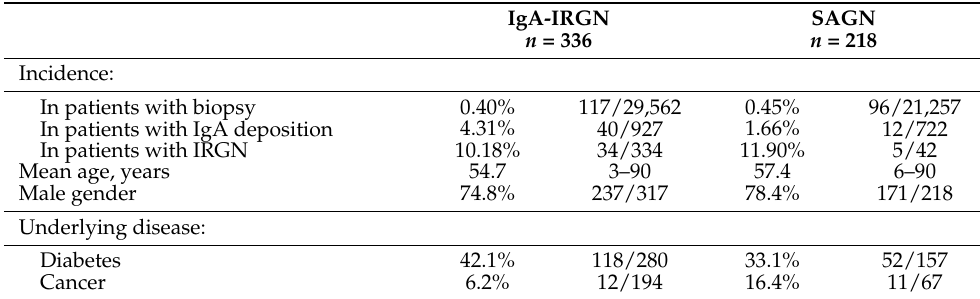
Table 1. Characteristics of the reported patients with IgA-IRGN or SAGN.